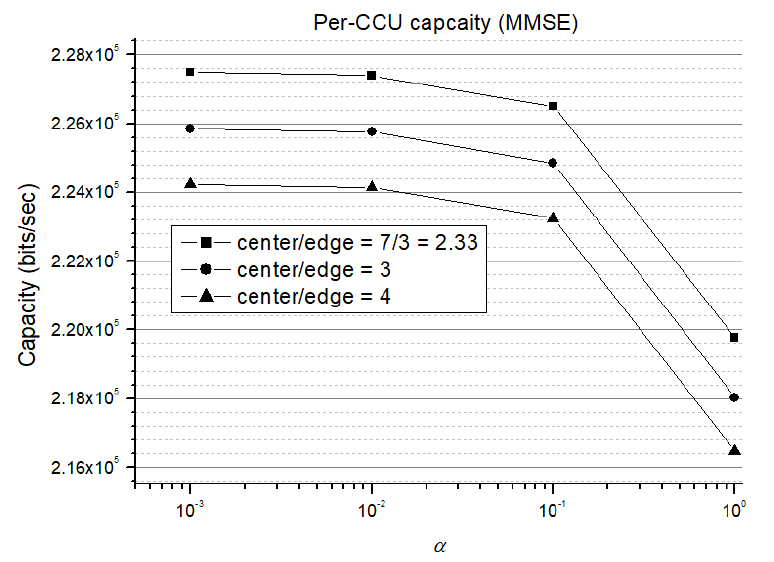
Figure 14. Per-CCU Capacity comparison between different values of center-edge area ratio for MU-network MIMO with MMSE joint preprocessing.